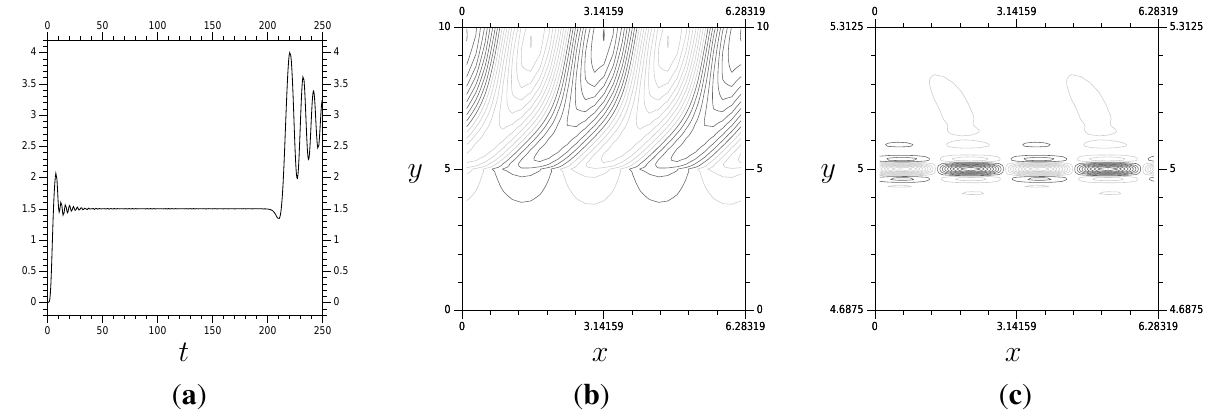
system. Notice that F ( t ) (the x averaged 6 { } t , 1 , β = 1 , δ = 0 . 2 , and no viscosity. 5